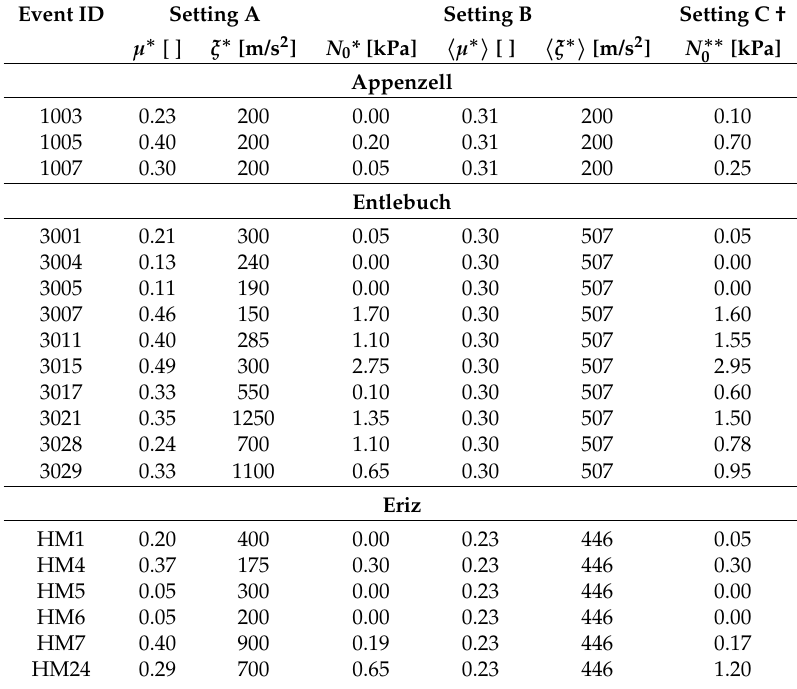
Table 2. Back-calculated resistance values for all parameter settings used in this study. Event ID Setting A Setting B Setting C † µ ∗ [